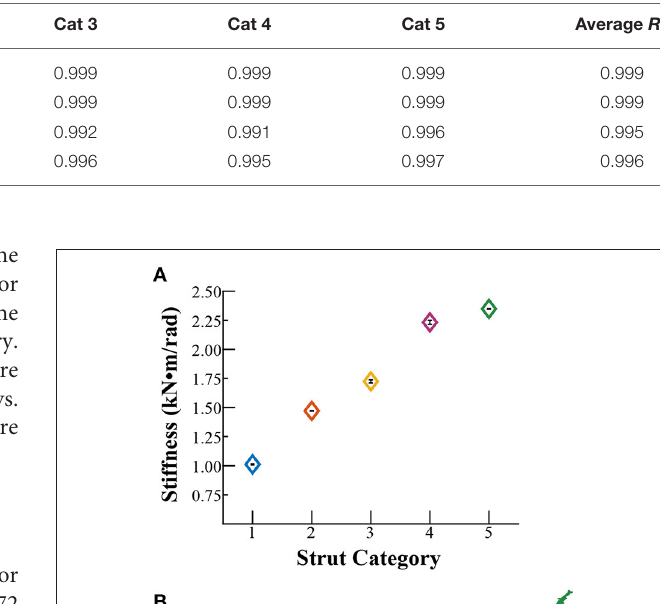
TABLE 1 | Average R 2 values for linear and 2nd degree polynomial curvilinear moment versus angle relationships for each strut stiffness category (Cat).